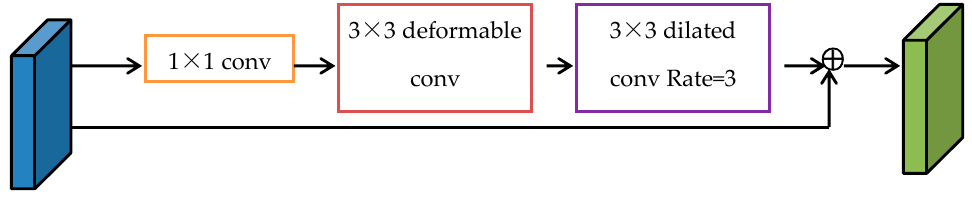
Figure 10. COT module structure.